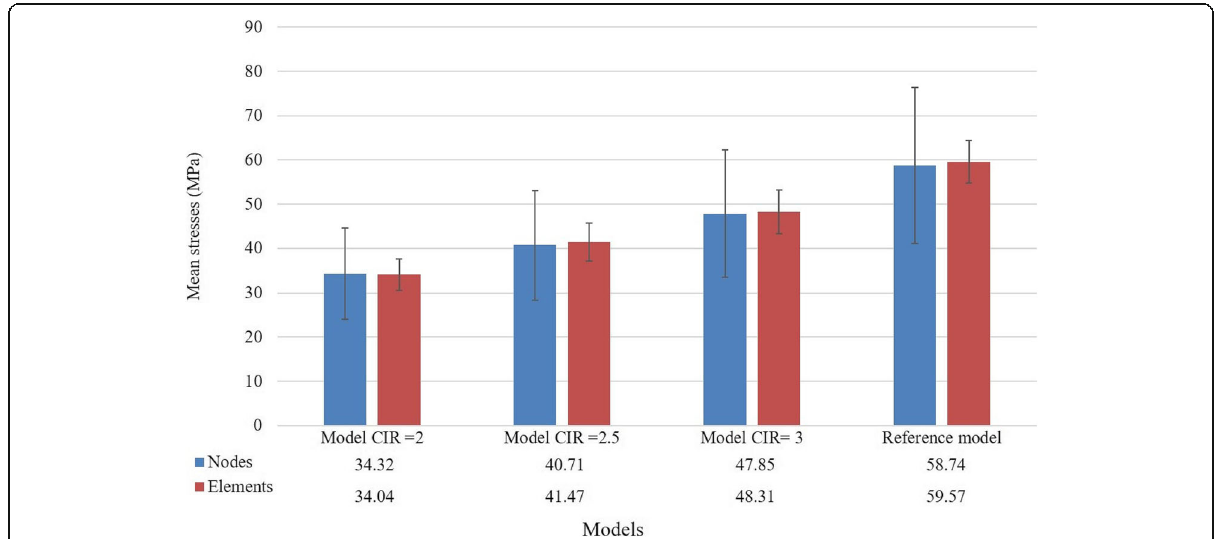
Fig. 8 Evolution of the median stresses predicted in the areas of interest with the change in the prosthetic height. It is possible to observe that the increase in the CIR and in the prosthetic height corresponds to an increase in the stress predicted